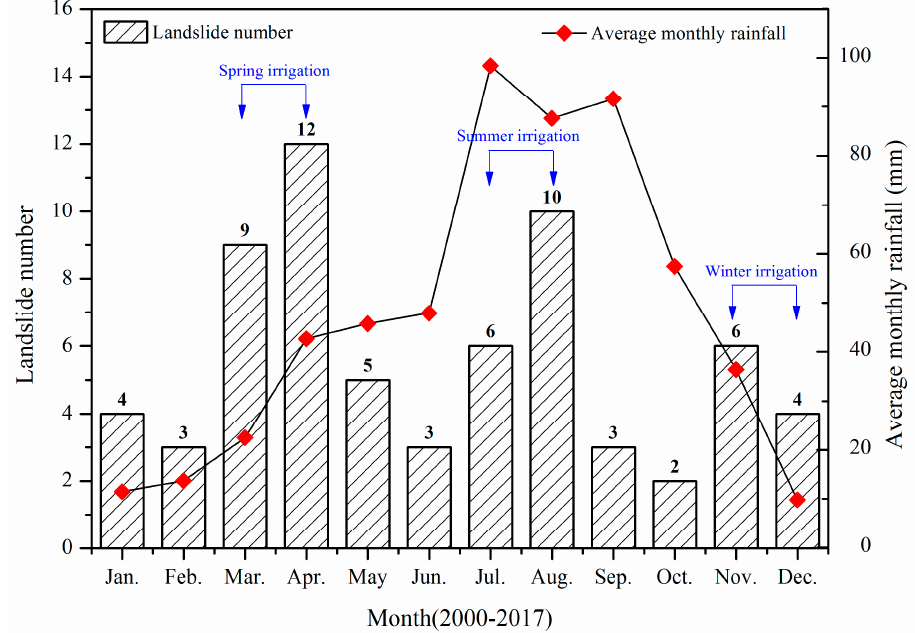
Figure 2. Monthly average precipitation distribution on the South Jingyang Plateau from 2000 to 2017.